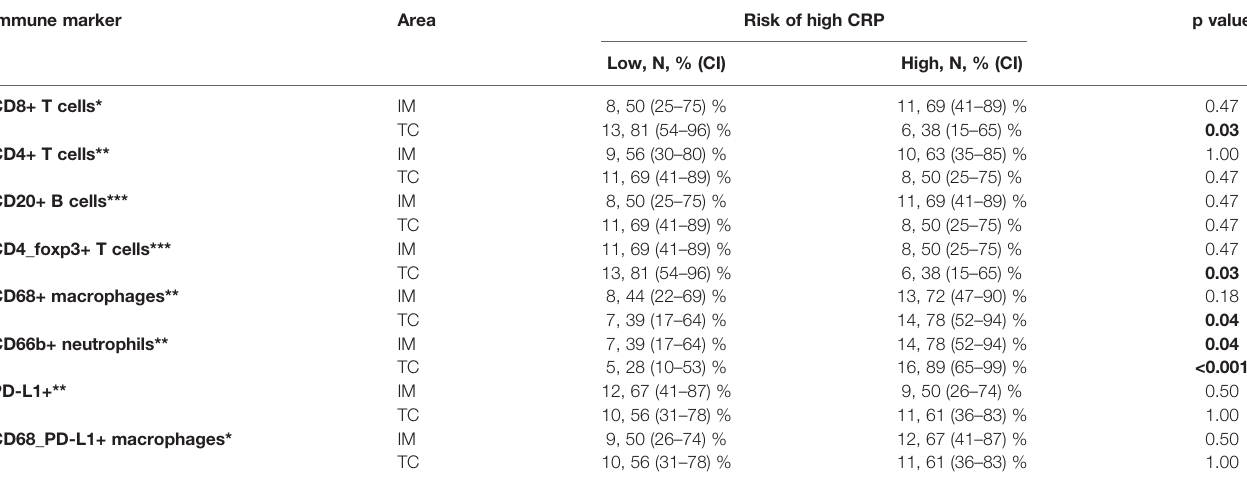
TABLE 3 | Associations between selected immune markers and systemic in fl ammation in colon cancer patients. Immune